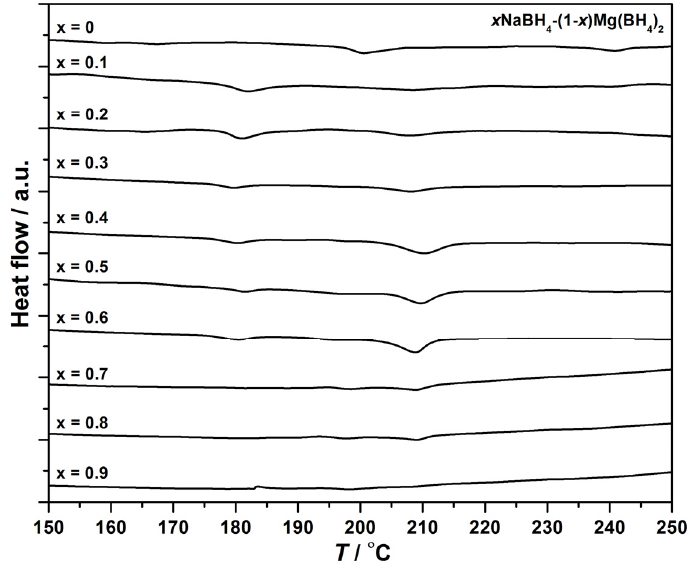
Figure 1. Normalized DSC curves of Mg(BH 4 ) 2 ( x = 0) and x NaBH 4 –(1 − x )Mg(BH 4 ) 2 , x = 0.1 to 0.9, in the temperature range of 150 to 250 °C, ∆ T / ∆ t = 5 °C/min.